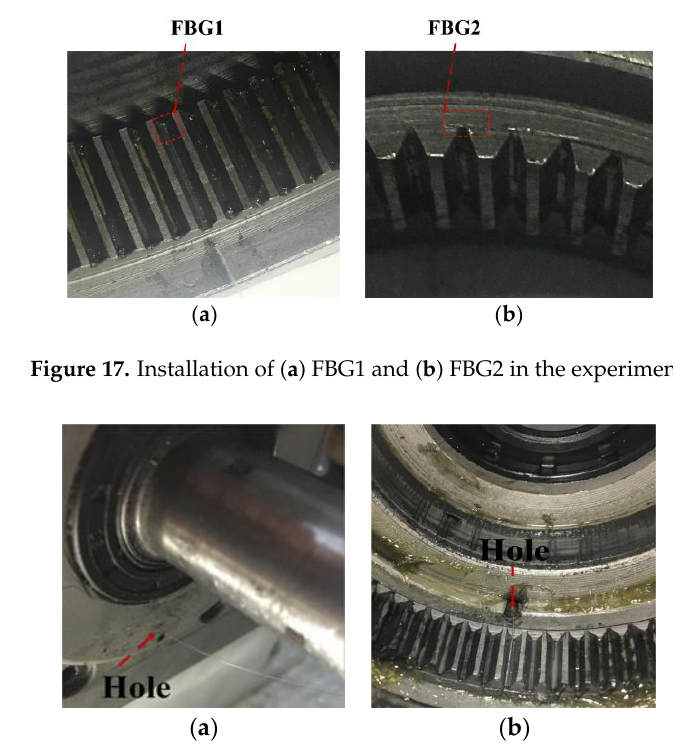
Figure 18. Extraction of the optical fiber: ( a ) a view inside the gearbox; ( b ) a view outside the gearbox.